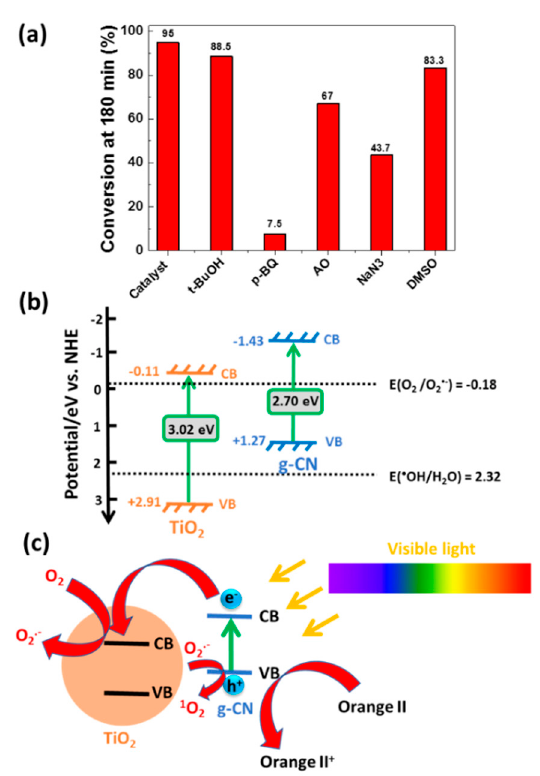
Figure 9. ( a ) Photodegradation of Orange II under visible light irradiation using the g-CN/TiO 2 catalyst in the presence of reactive species trapping compounds, ( b ) band structure of the g-CN/TiO 2 photocatalyst, and ( c ) schematic illustration of the delocalization of charge carriers and of the formation of reactive species involved in the photodegradation of Orange II.